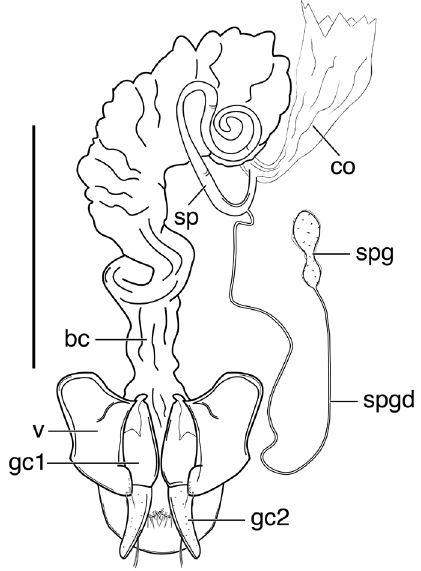
Figure 60. Line drawing of female reproductive tract of Selenophorus striatopunctatus species group, ventral aspect, S. striatopunctatus Putzeys. Legend: bc bursa copulatrix co common oviduct gc1 gonocoxite 1 gc2 gono-